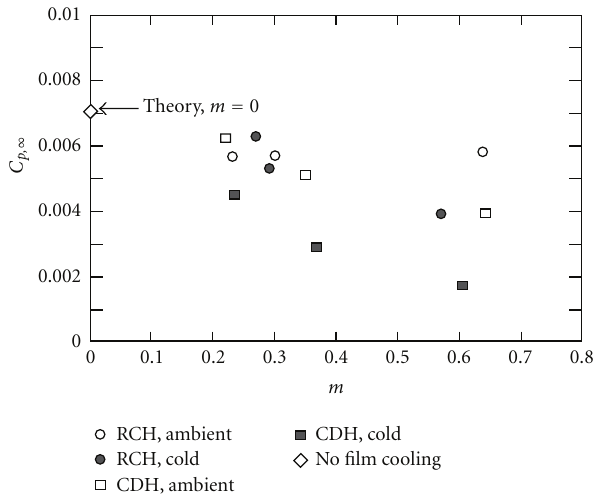
Figure 9: Normalized total pressure losses in the freestream flow due to trailing edge, oblique shock waves as dependent upon blowing ratio for round cylindrical holes (RCHs) and conical di ff used holes (CDHs), for the symmetric airfoil with film cooling